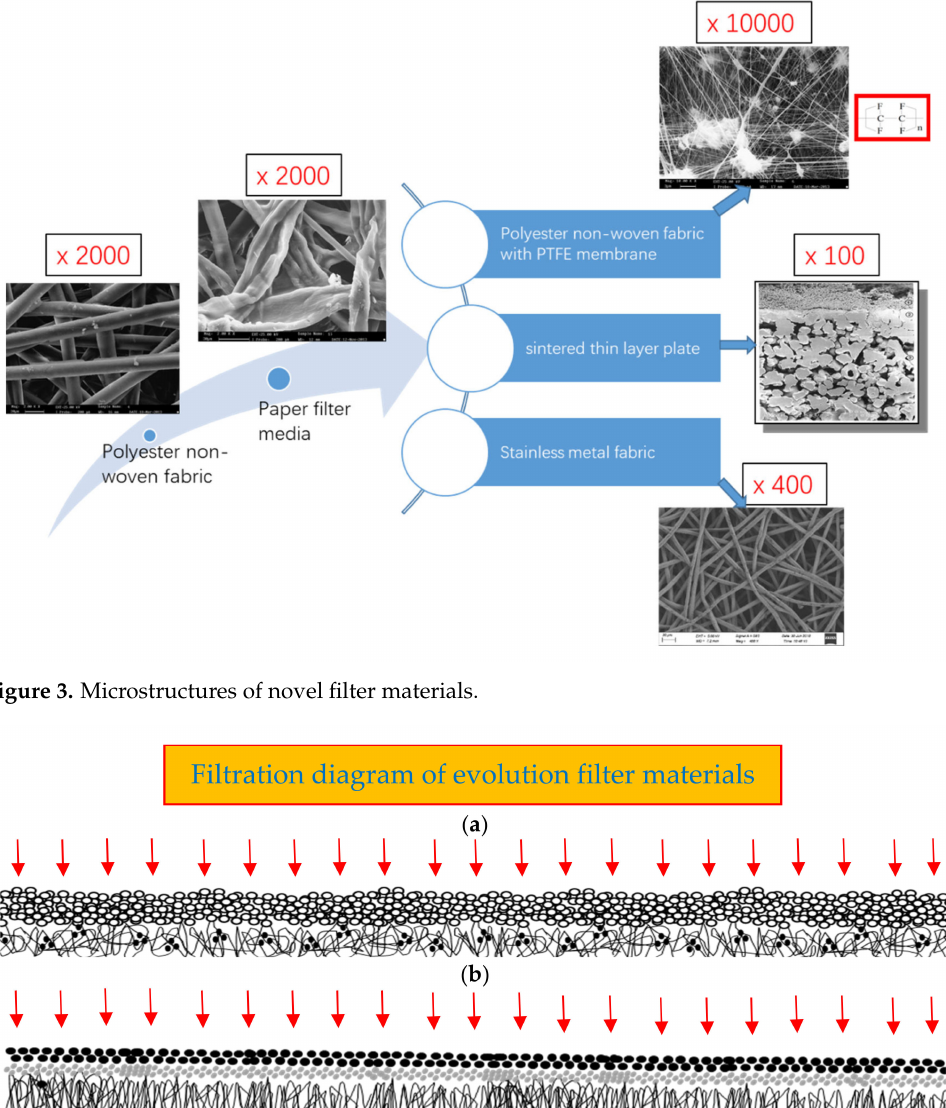
Figure 4. Filtration differences of the evolution filter medium. ( a ) Conventional fiber needled felt and ash layer. ( b ) Surface treatment with polytetrafluoroethylene fibers and ash layer. ( c ) Metal fiber and ash